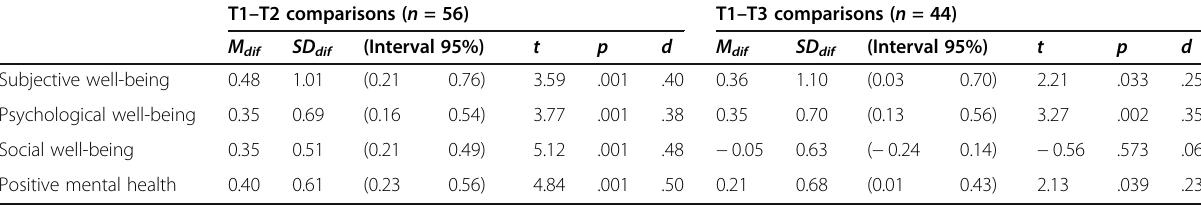
Table 4 Change assessment between baseline and post-intervention (T1 – T2), and between baseline and 6-month follow-up (T1 – T3) T1 – T2 comparisons ( n = 56) T1 – T3 comparisons ( n = 44) M